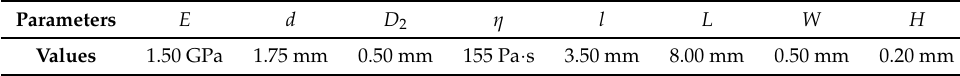
Table 2. Critical feed rate